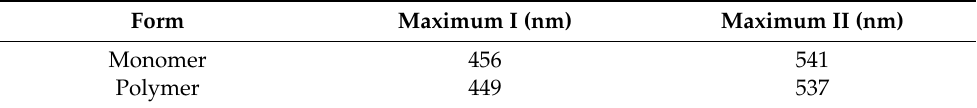
Figure 4. Comparison of UV-vis spectra of monomer and polymer form of NR ( a ) dissolved in DMSO and ( b ) depending on the pH in 0.05 M MES solution with 0.1 M NaCl. Table 2. The position of absorption maxima of the UV-vis bands of the monomer and polymer NR spectra dissolved in DMSO.